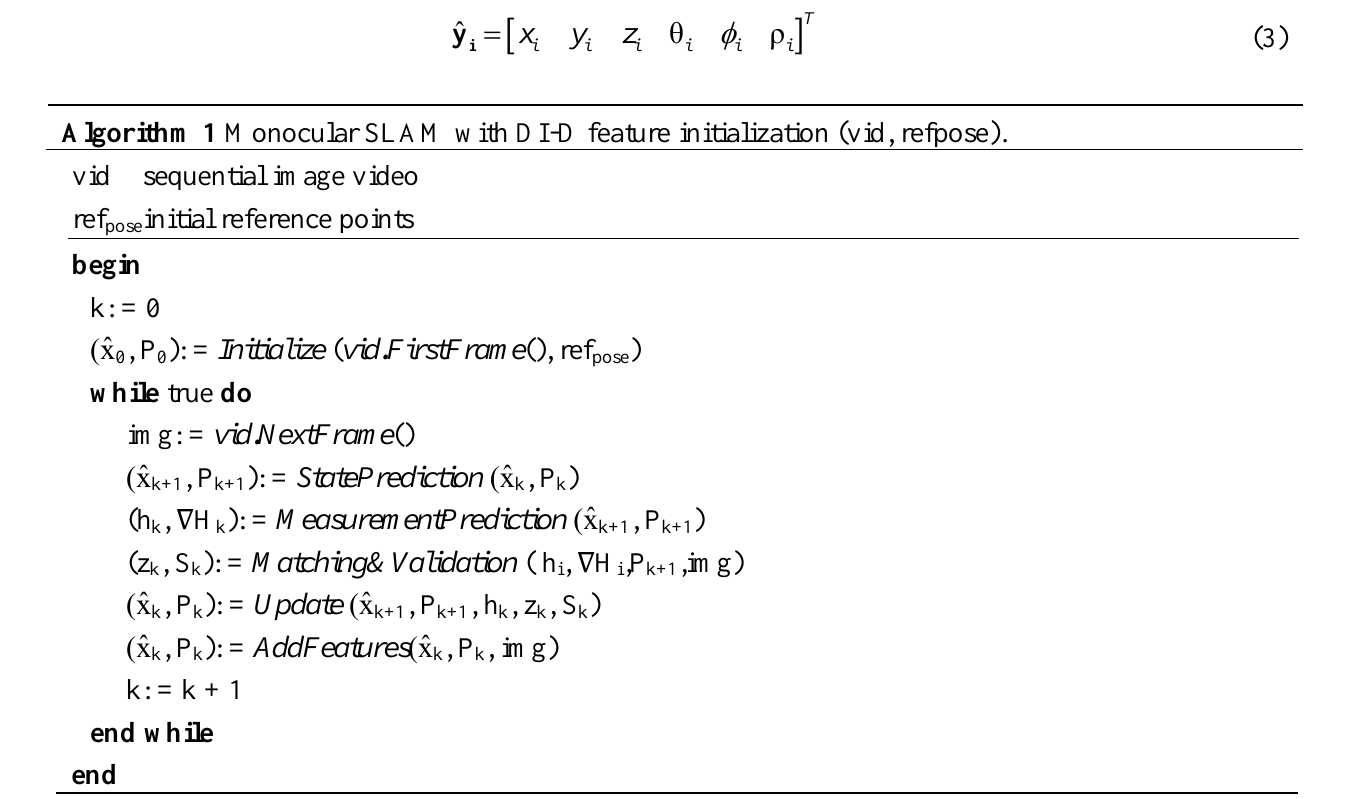
Figure 1. Inverse-depth problem with PnP scale initialization, adapted from reference